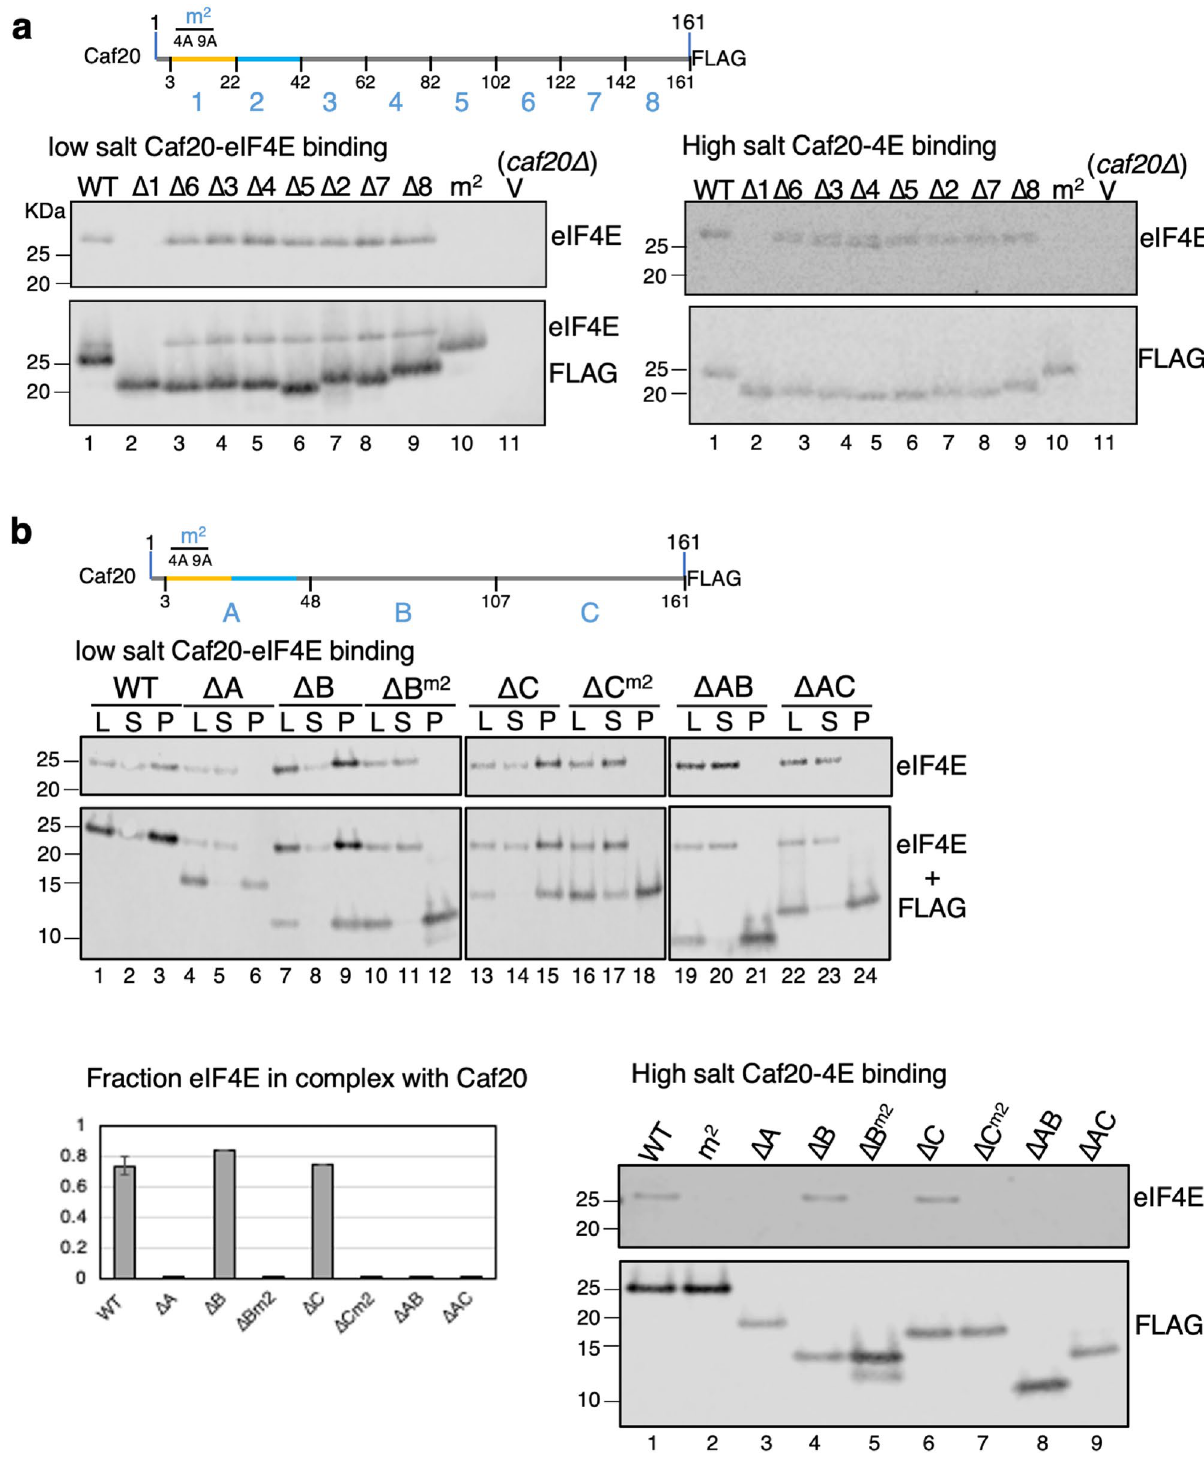
Figure 2. The canonical-binding motif is the only critical element in Caf20 for Binding to eIF4E. Co-immunoprecipitation of eIF4E with CAF20 -FLAG deleted for specific regions with eIF4E from cell protein extracts. ( a ) 20-residue deletions ∆1–∆8. Western blots of Flag peptide eluted eIF4E and Flag-tagged Caf20 from total cell extracts. On the left, IP washed in low salt buffer (100 mM KCl). On the right, western blots of Caf20-FLAG co-IPs performed as in the left panel except that pellets were washed in high salt buffer (1 M KCl). ( b ) Co-immunoprecipitation as in panel ( a ), but with larger elements removed. Top cartoon summarises the deletions. Western panels show Input (load, L), Unbound supernatant (S) and 3xFlag peptide eluted Pellets (P) for samples washed with 100 mM KCl. Lower panels show quantification of eIF4E bound (left) and 3xFlag peptide eluted fraction only for equivalent experiments with 1 M KCl buffer (right). Experiments performed 2–3 times with equivalent